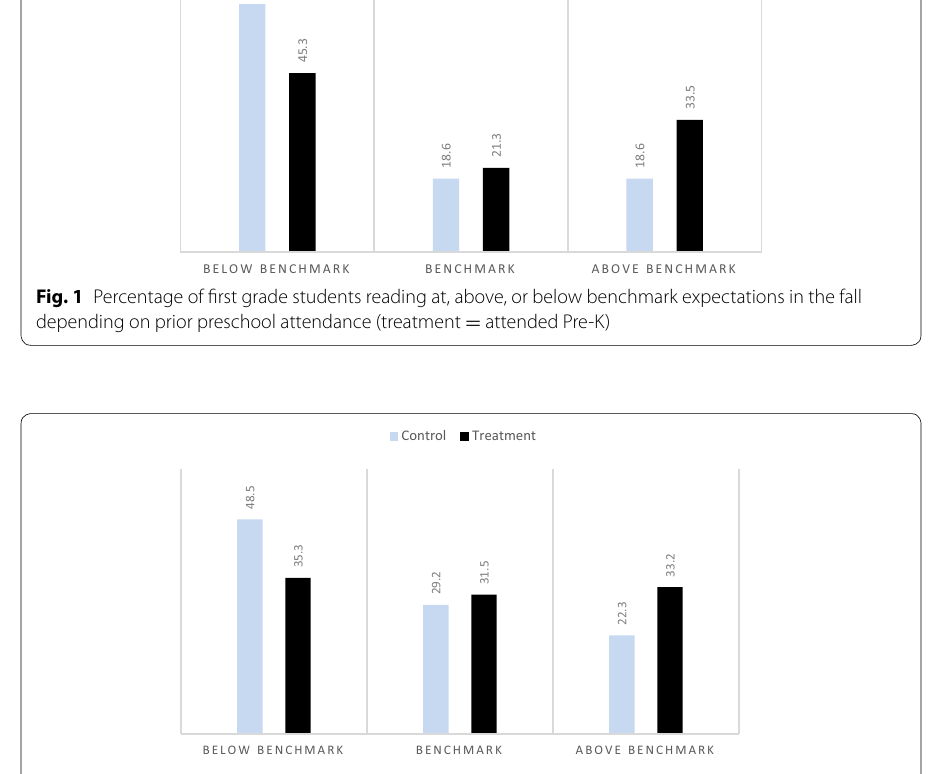
Fig. 2 Percentage of first grade students reading at, above, or below benchmark expectations at mid-year depending on prior preschool attendance (treatment